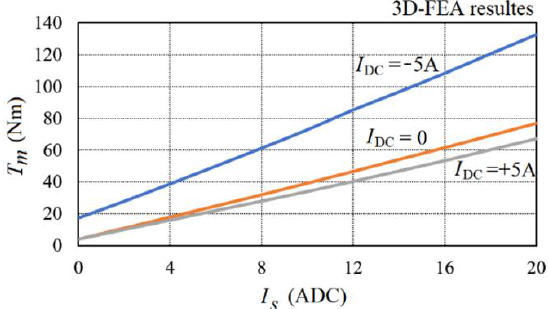
Figure 9. Maximum electromagnetic stator torque characteristics at the different control coil currents.